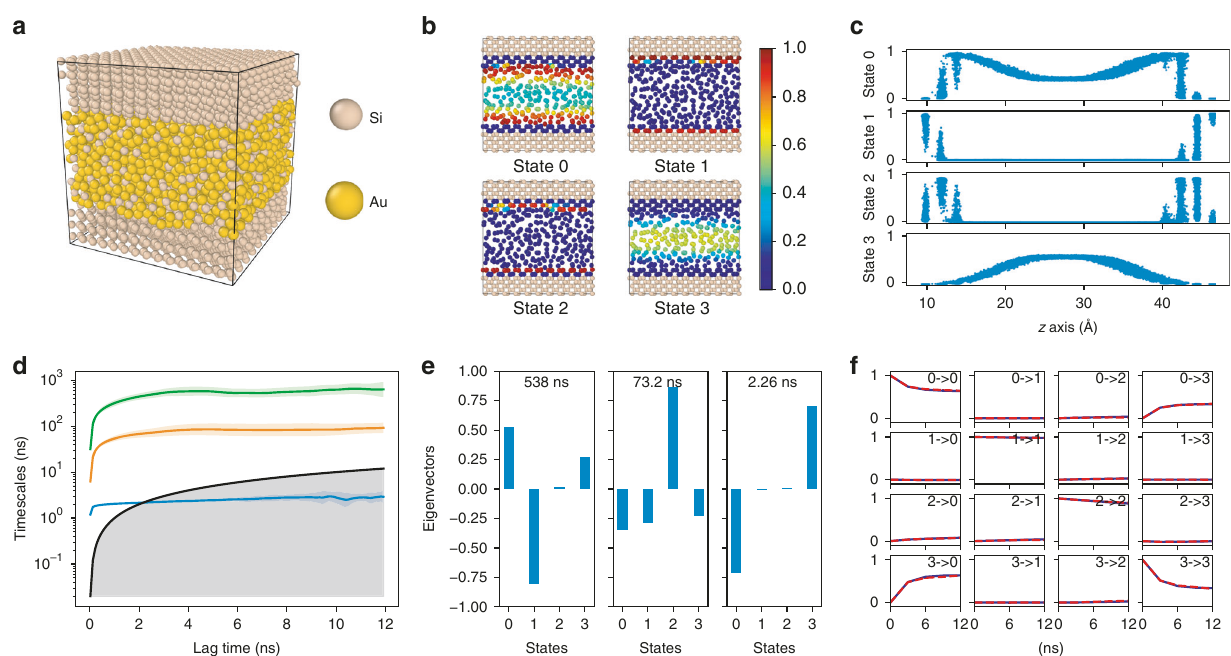
Fig. 3 A four-state dynamical model learned for silicon atoms at a solid – liquid interface. a Structure of the silicon-gold two-phase system. b Cross section of the system, where only silicon atoms are shown and color-coded with the probability of being in each state. c The distribution of silicon atoms in each state as a function of z -axis coordinate. d Relaxation timescales computed from the Koopman models as a function of the lag time. The black lines are reference lines where the relaxation timescale equals to the lag time. e Eigenvectors projected to each state for the three relaxations of Koopman models at τ = 3 ns. f CK test comparing the long-time dynamics predicted by Koopman models at τ = 3 ns (blue) and actual dynamics (red). The shaded areas and error bars in d , f report the 95% con fi dence interval from fi ve sets of Si atoms by randomly dividing the target atoms in the test